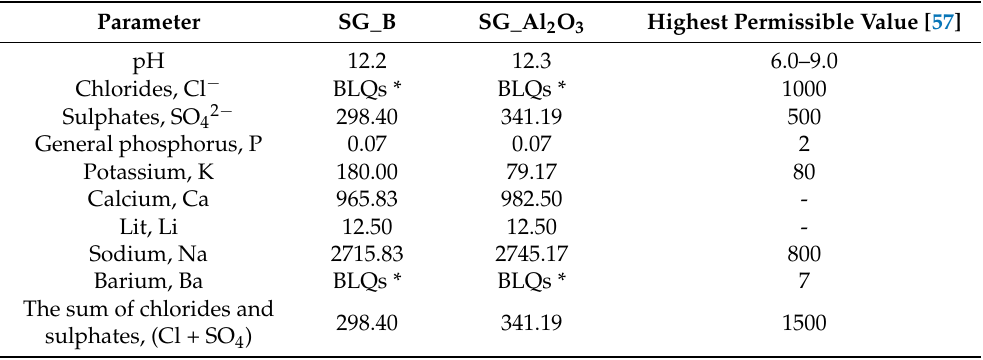
Table 7. Leachability of pollutants from ground rock wool-based geopolymer binders expressed as mg/L dry weight (except for pH).